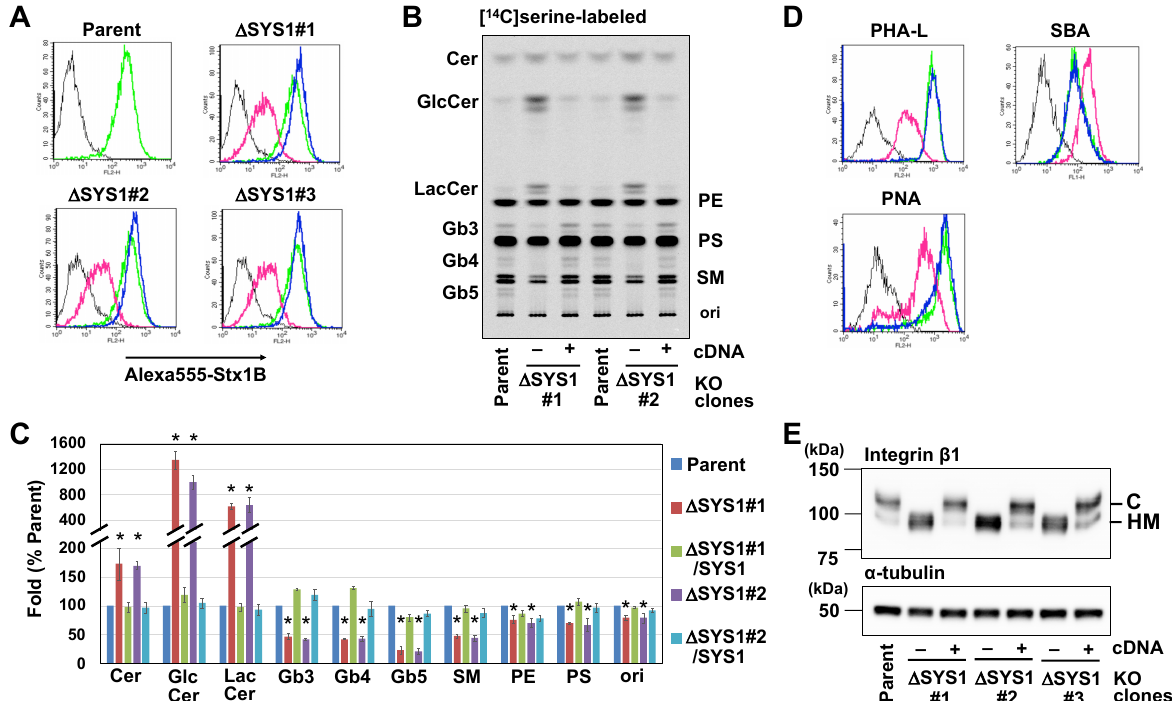
Figure 4. Glycan defects in ∆ SYS1 cells. ( A ) Surface binding of STx on ∆ SYS1 cells and ∆ SYS1/SYS1 cells. Cells were stained with (green, magenta, and blue lines) or without (black line) Alexa555-labeled STx1 B subunit (Alexa555-STx1 B) and analyzed using FACS. Green lines indicate staining in parent cells. Black and magenta lines indicate staining in ∆ SYS1 cells. Blue lines indicate staining in ∆ SYS1/SYS1 cells. ( B ) GSL metabolic analysis of ∆ SYS1 cells and ∆ SYS1/SYS1 cells. Cells were labeled with [ 14 C]serine, and labeled lipids were separated on a TLC plate. ( C ) Quantification of labeling experiments shown in B. The relative amount of each [ 14 C]serine-labeled lipid is expressed as a percentage of band intensity in parent cells and is representative of the mean percentage ± SD obtained from three independent experiments. The Bonferroni corrected t -test was used for multiple comparisons. * p < 0.0125. ( D ) Surface binding of lectins on ∆ SYS1 cells and ∆ SYS1/SYS1 cells. Cells were stained with (green, magenta, and blue lines) or without (black line) FITC-conjugated lectins and analyzed using FACS. Green lines indicate staining in parent cells. Black and magenta lines indicate staining in SYS1 -KO ( ∆ SYS) cells. Blue lines indicate staining in SYS1 -rescued cells. ( E ) Western blot analysis of Integrin β 1 in ∆ SYS1 cells and ∆ SYS1/SYS1 cells. Cell lysates were immunoblotted with anti-integrin β 1 antibody (top) and anti- α -tubulin (bottom). C indicates complex-typed glycoproteins, and HM indicates high mannose-typed